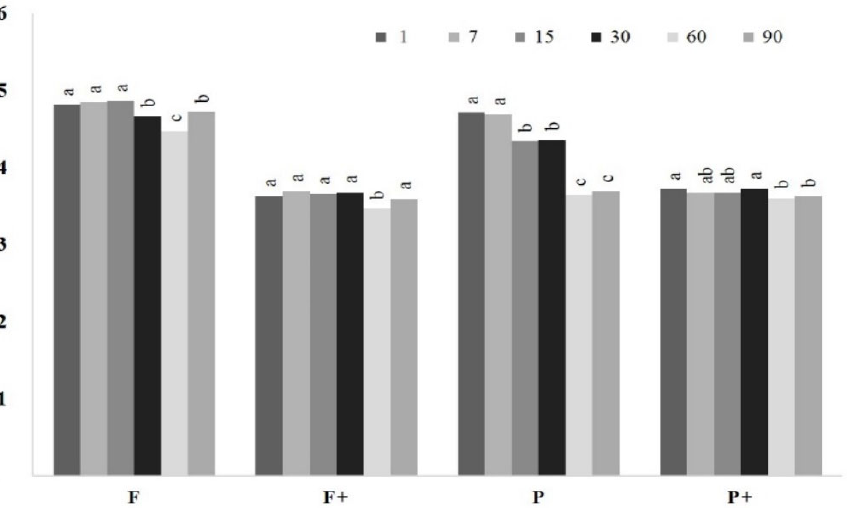
Figure 3. pH values of fresh and pasteurized samples during the storage period (from 1 to 90 days). Letters show differences by Tukey’s multiple range test.